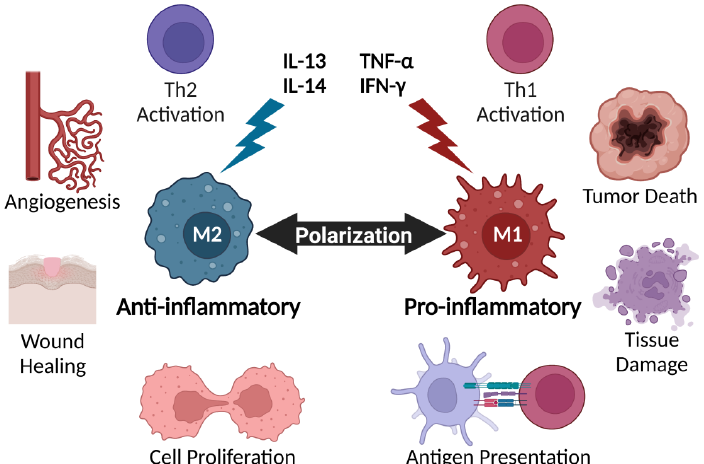
Figure 1. Macrophage polarization is highly regulated by cytokines. Generally, inflammatory cyto- kines promote M1-type macrophage functions that lead to enhanced Th1 activation, tumor killing, tissue damage, and antigen presentation. In contrast, anti-inflammatory cytokines induce macro- phages to become more M2-like, leading to increased tumor-promoting and immunosuppressive responses, such as Th2 activation, angiogenesis, wound healing, and cell proliferation.